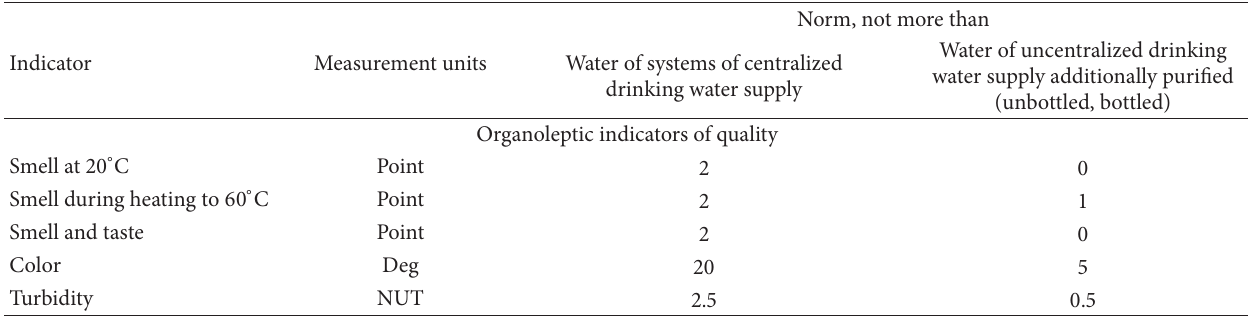
Table 4: Organoleptic indicators of drinking water